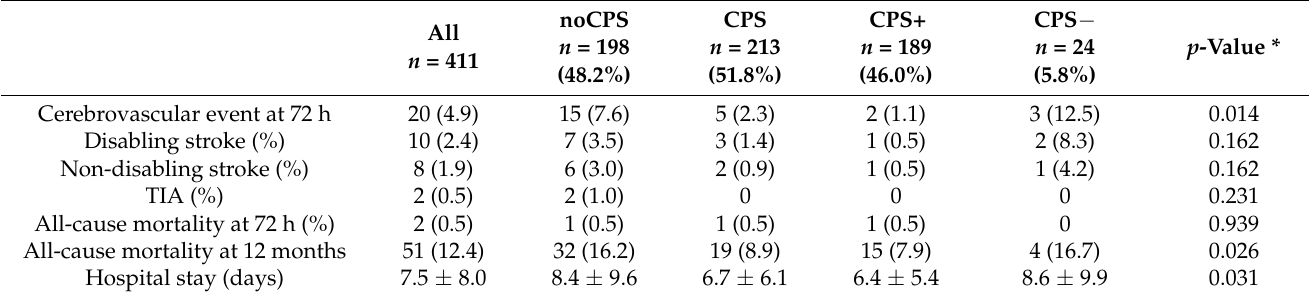
Table 2. Outcome